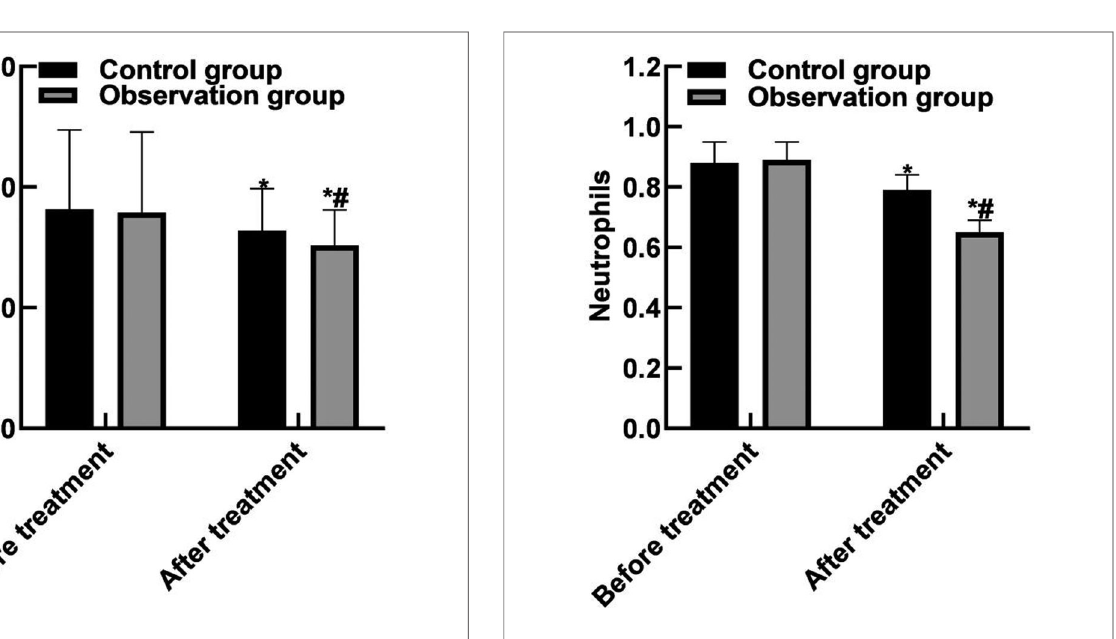
FIGURE 2 | Comparison of blood routine indexes. Note: Compared with before treatment, * P <0.05; Compared with the control group, # P <0.05.